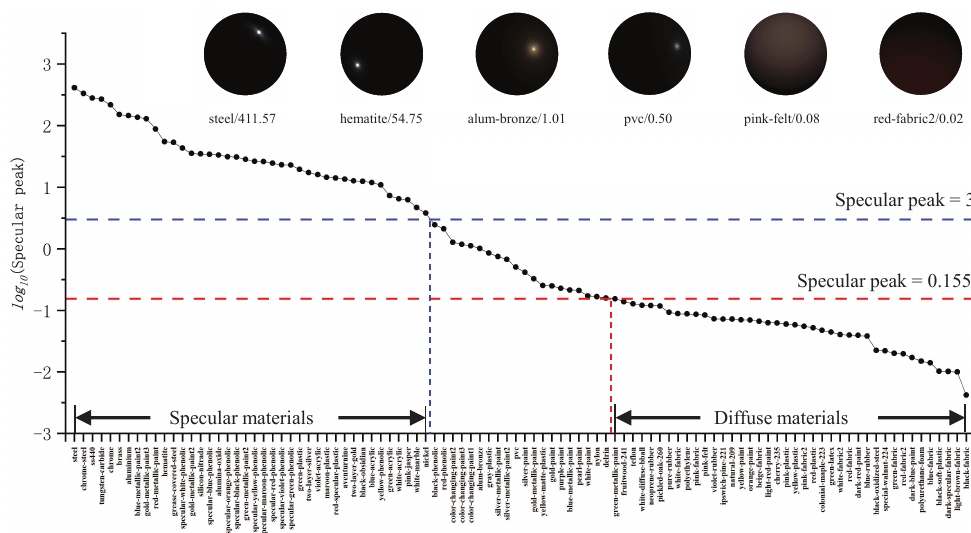
Figure 4. The specular peaks [36] of 100 MERL materials [35]. The vertical coordinate represents the ( specular peak ) for a better display. value of the specular peak. We scaled the values through log 10 The horizontal coordinate represents the name of each material in the dataset of 100 MERL materials. The spheres rendered by different materials are exhibited at the top of the pictures. Corresponding names and specular peaks are shown at the bottom of the object